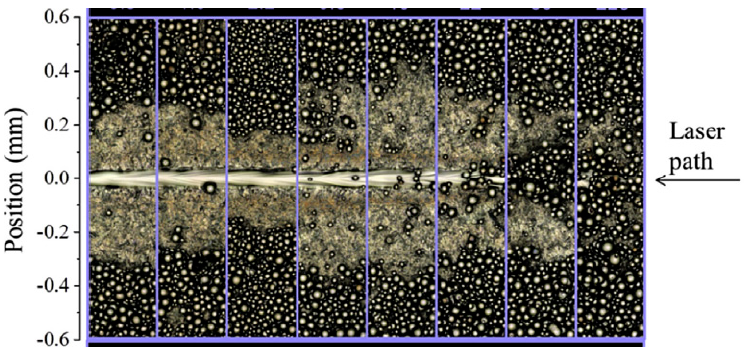
Figure 3. Montage of optical micrographs of a solidified melt track (225 W, 1.4 m/s, Ti-6Al-4V). Adapted from Reference [34] with permission from Elsevier.